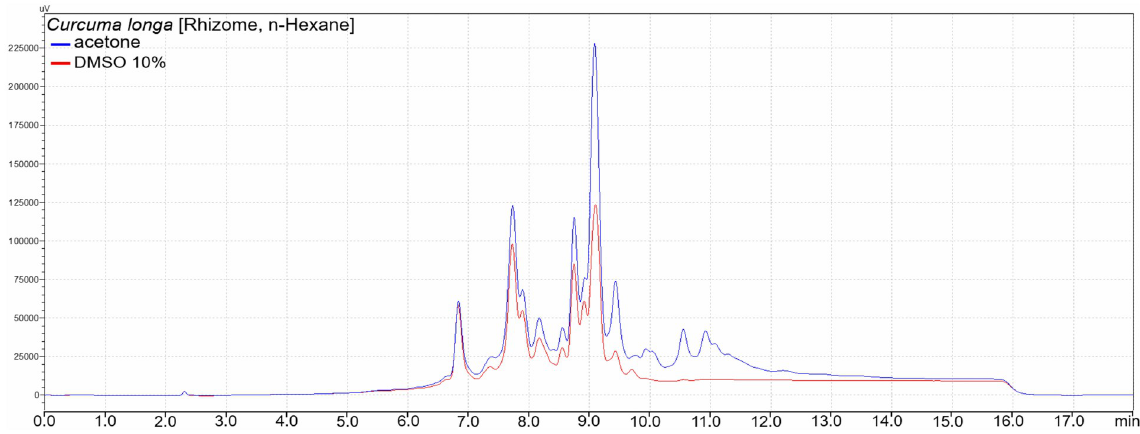
Fig 1. An overlay of UV chromatograms of acetone (blue) and DMSO (red) based working solutions of an n-hexane rhizomes extract of C . longa . Qualitative similarity and higher quantities of phytochemicals observed in the acetone based working solution, which had better solubility compared to that of DMSO.